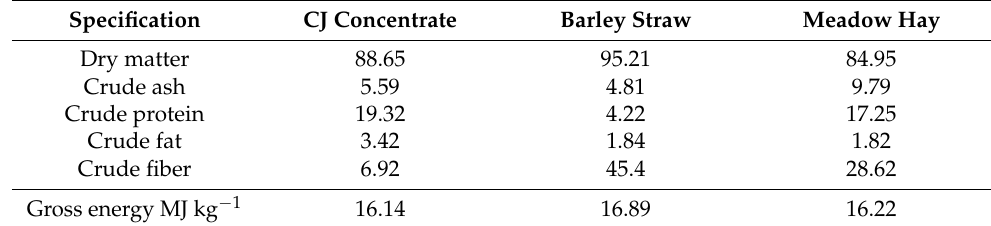
Table 1. Chemical composition (% of fresh